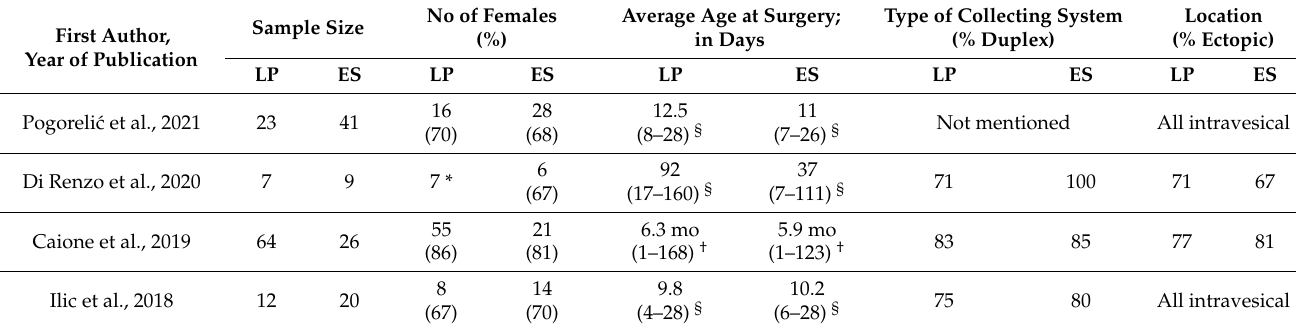
Table 1. Characteristics of included